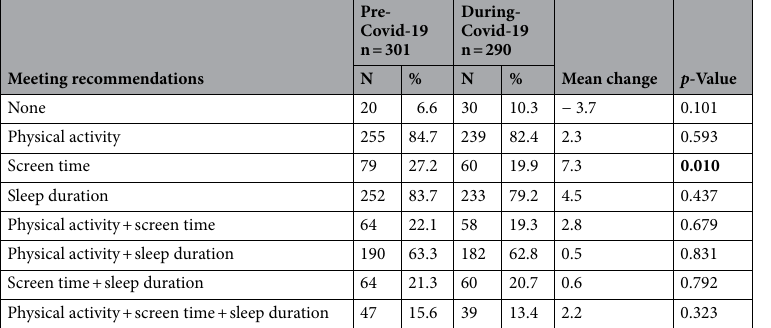
Table 3. Proportion of WHO 24-h MG recommendations and combinations in pre-and during COVID-19 pandemic. Bold value indicates a factor of significant relevance. Meeting therecommendations is defined as 180 min of total PA including more than 60 min/day of moderate-to-vigorous PA, no more than 60 min/day for screen time, and between 10 and 13 h/day for sleep duration. PA was based on accelerometer-determined while and sleep duration and screen time were